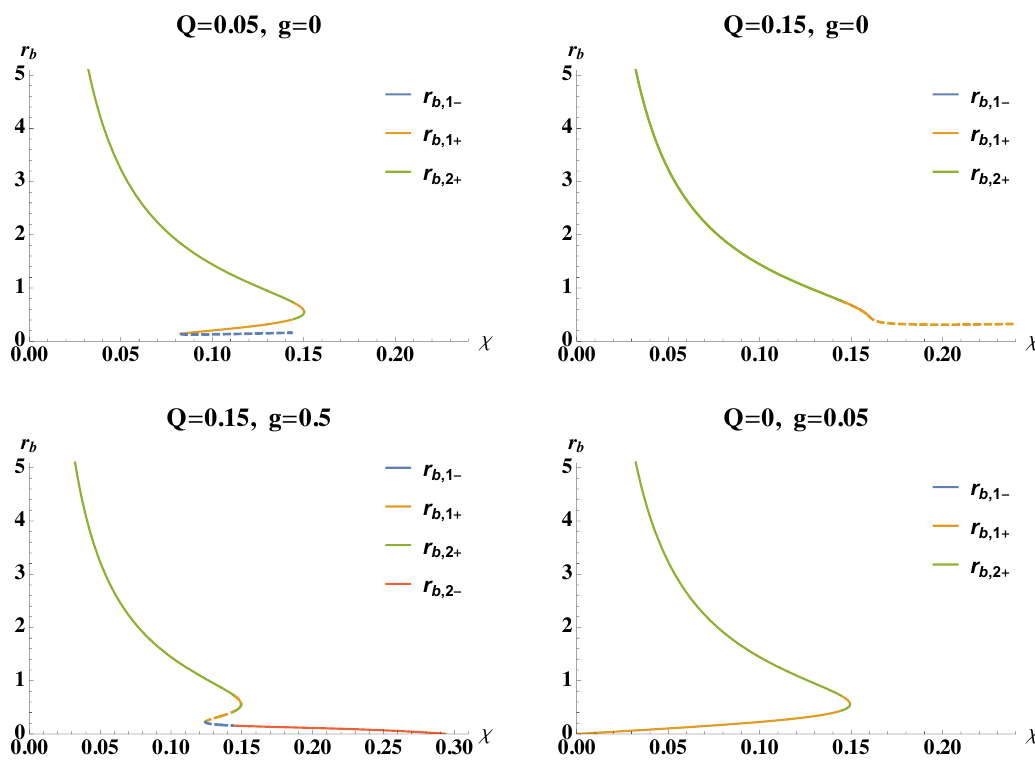
Figure 4 . The horizon radius of TB-AdS for κ = 1 vs. χ for fixed values of Q and g with G = l = 1 . The dashed lines correspond to negative entropy, and are not regarded as corresponding to physically admissible